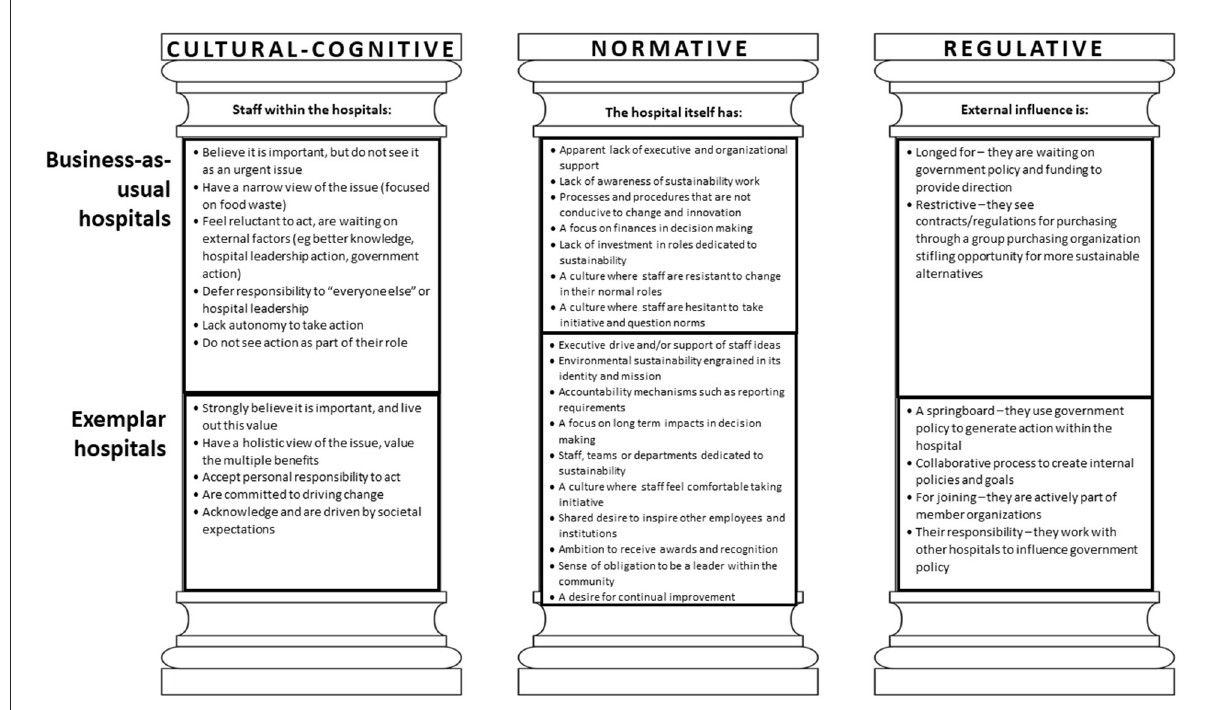
FIGURE1 Staff perspectives toward environmental sustainability of hospital foodservices aligned to the pillars of